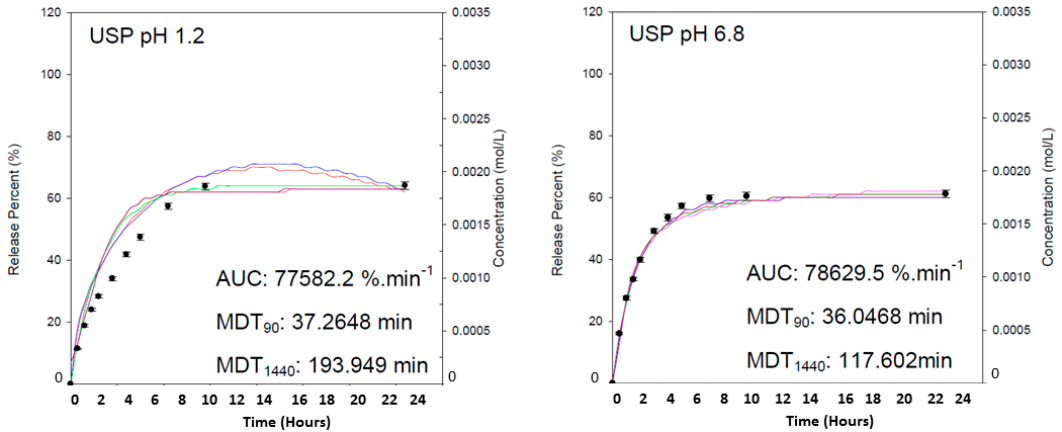
Figure 10. Drug release profiles using theophylline as a prototype drug, evaluating the release kinetics of the hydrogel over 24 h in gastric and intestinal simulated fluids.